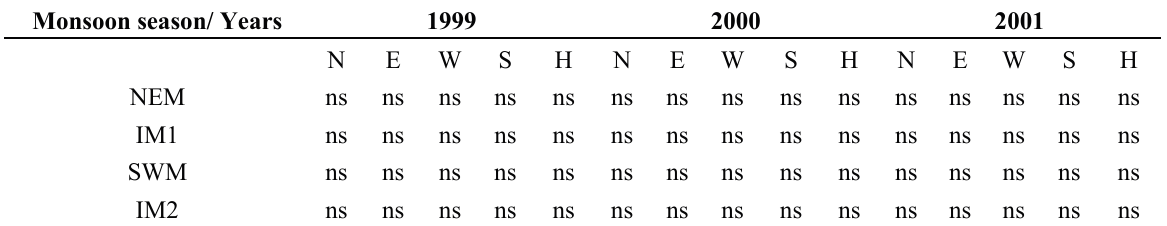
Table A2. T -test result of the TRMM 3B43 version 6 with version 7 for each corresponding monsoon seasons in every